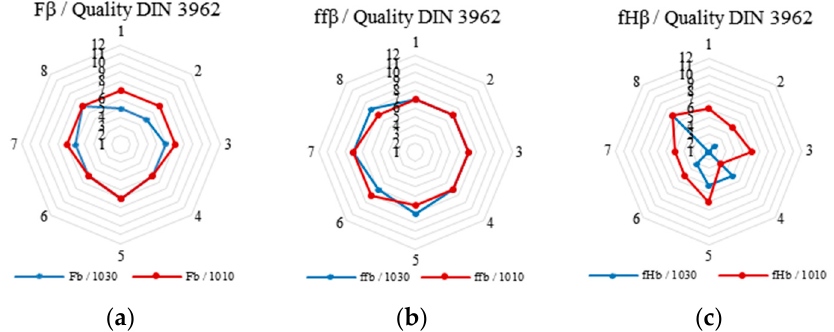
Figure 11. Comparison of gear quality in flank direction: ( a ) overall flank deviation, for 1030 and 1010 inserts; ( b ) flank form deviation, for 1030 and 1010 inserts; ( c ) flank angle deviations for 1030 and 1010 inserts.